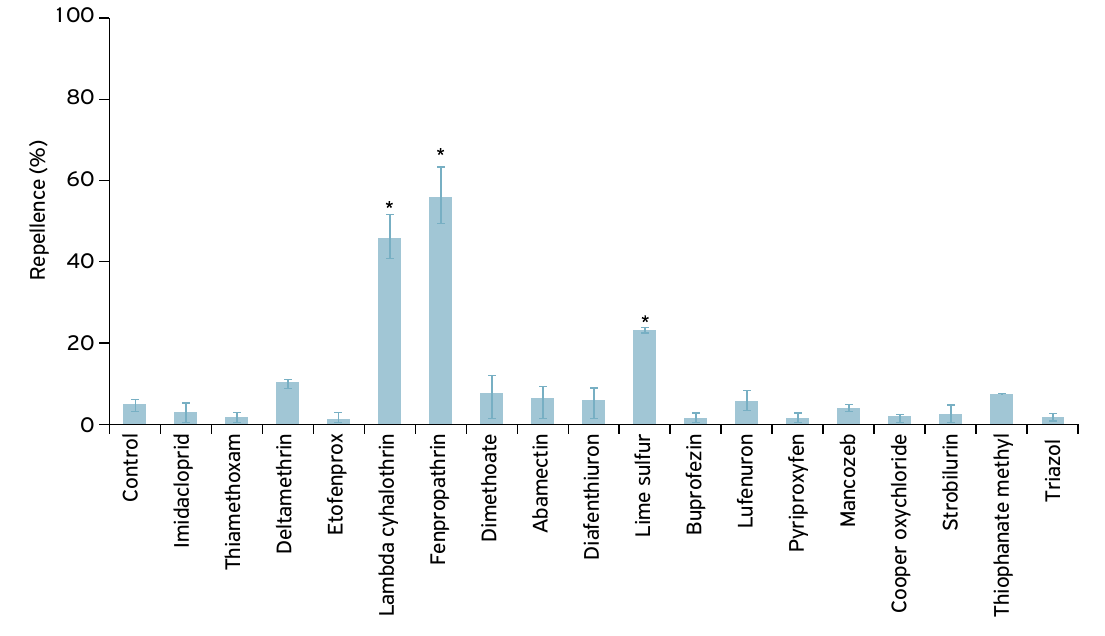
Figure 3. Pesticide effect on repellence (%) to Panonychus citri